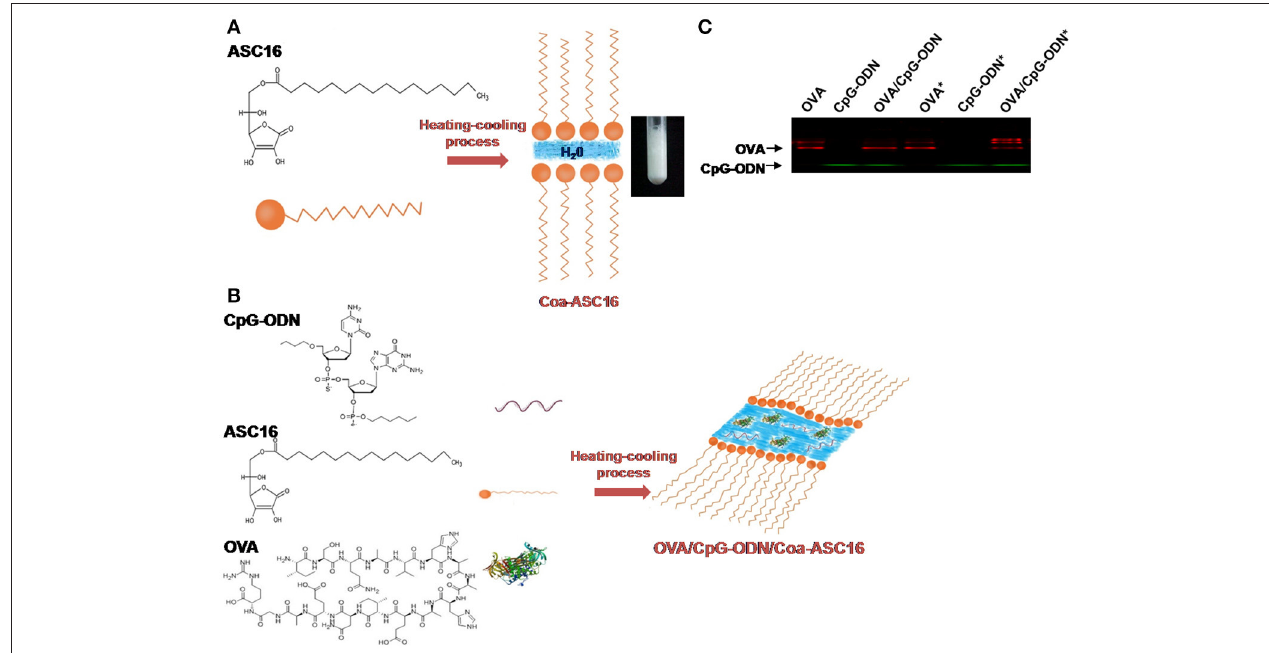
FIGURE 1 | The formulation of OVA and CpG-ODN with the nanostructure. (A) Schematic representation of Coa-ASC16 and photographic image. (B) Schematic representation of OVA/CpG-ODN/Coa-ASC16. (C) Native-PAGE of formulations using IRDye ® 680RD OVA and 5 ′ IRDye ® 800CW CpG-ODN comparing non-treated and heat-treated samples (marked with